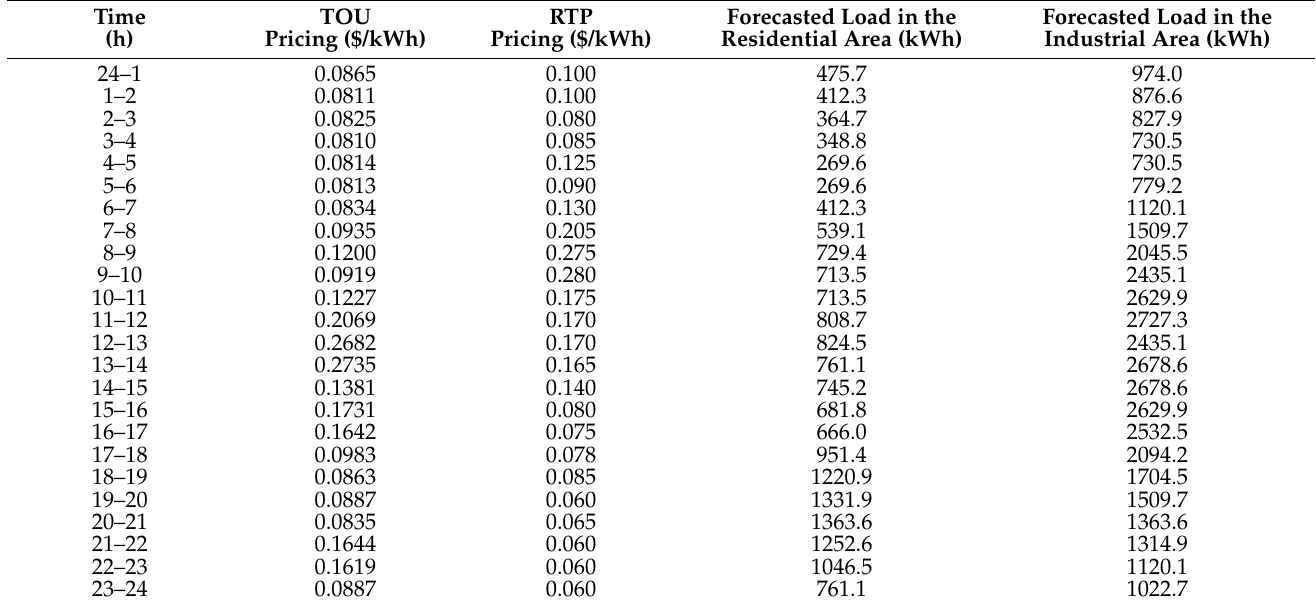
Table 3. Hourly pricing and hourly load forecast.